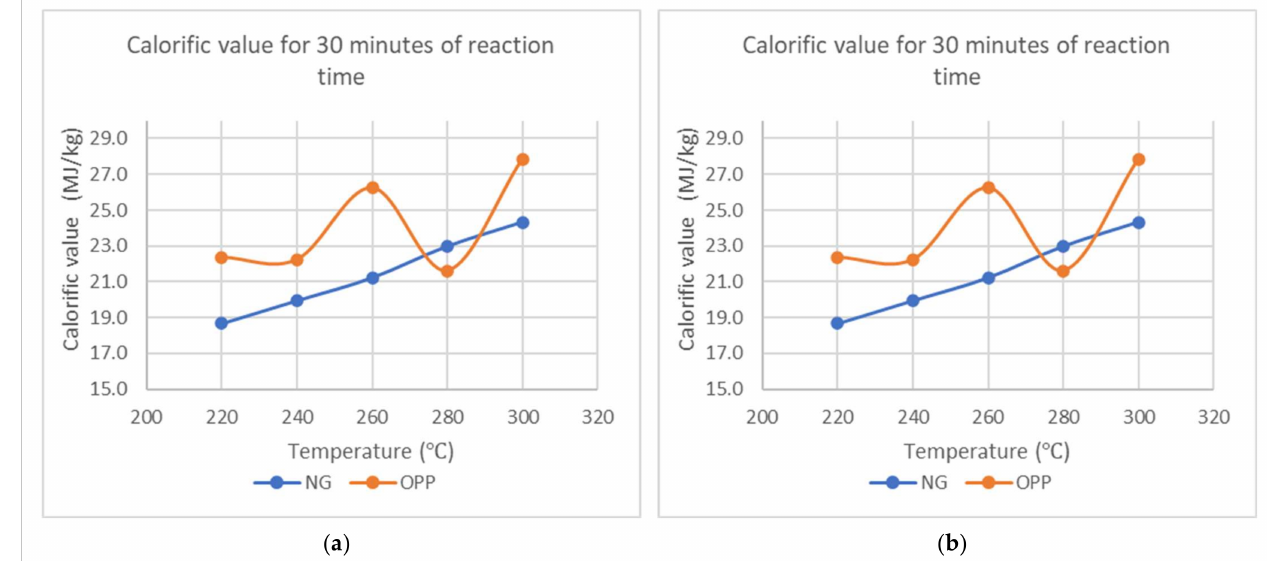
Figure 5. Calorific value of torrefied biomasses ( a ) against temperature at constant reaction time of 30 min and ( b ) against reaction time at constant temperature of 260 ◦ C.